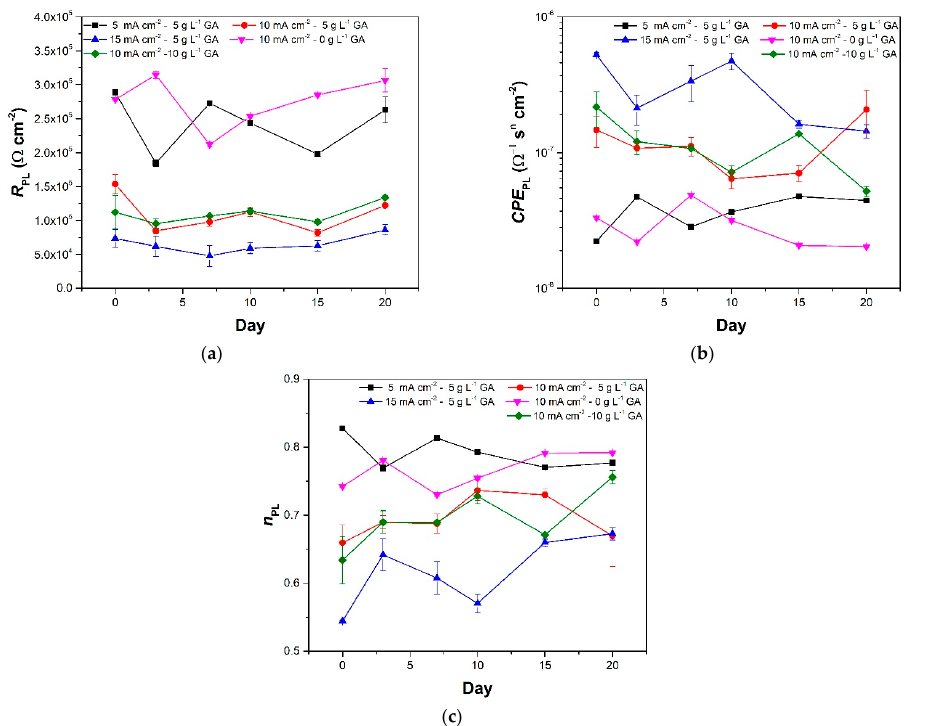
Figure 7. Fitted values of the porous layer ( a ) resistance, ( b ) constant phase element, and ( c ) n of the anodized aluminum samples at different times during the prolonged immersion in 3.5 wt.% NaCl. The error bars in the plots pertain to the standard error based on three replicates.